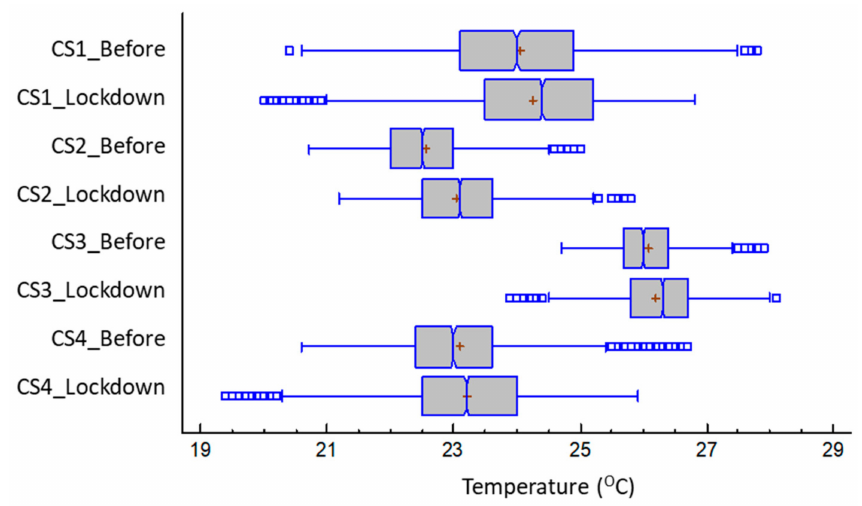
Figure 6. The temperature in the di ff erent case studies before and during the lockdown in Madrid.